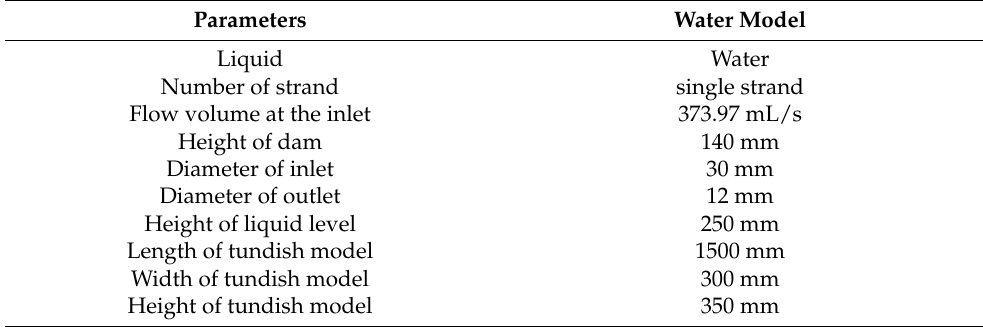
Figure 1. Water model of tundish: (a) Schematic diagram of experimental system; (b) Front view of tundish; (c) Side view of tundish Table 1. Main dimensions and parameters for water